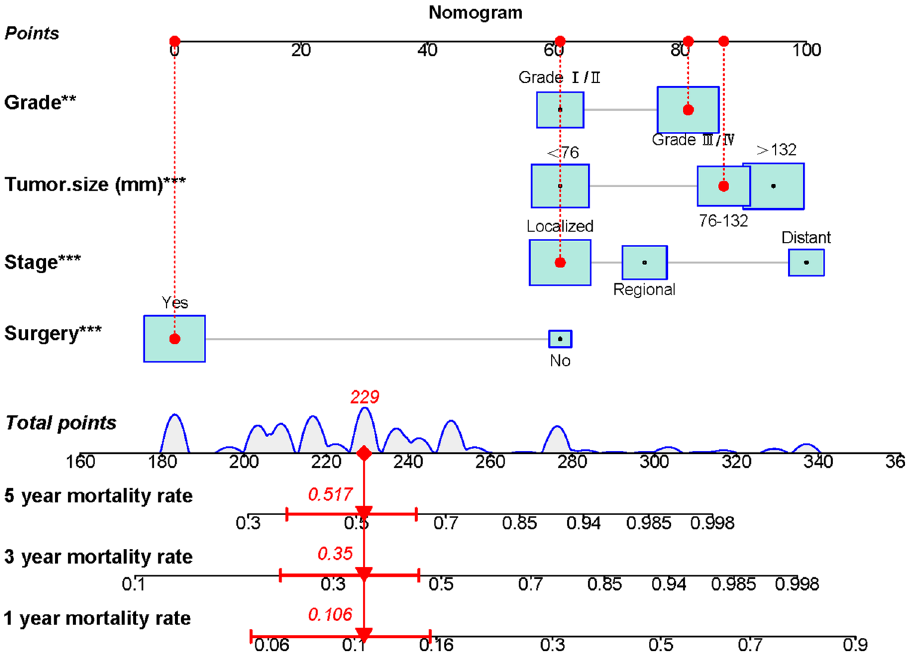
Figure 2. This prognostic nomogram predicts 1, 3, and 5 years OS probability in retroperitoneal leiomyosarcoma patients. Specifically, when a patient with primary retroperitoneal leiomyosarcoma comes to the clinic room for consulting his or her OS probability, we can sum each point of the above four independent prognostic factors to obtain a total point and draw a vertical line from total points row to the bottom timeline to obtain his or her mortality rate at the corresponding time. The survival probability at the corresponding time can be obtained by subtracting the mortality rate from 1. For example, a retroperitoneal leiomyosarcoma patient with a 100 mm localized metastasis and Grade III tumor and underwent surgery. The corresponding nomogram total points of this patients is 87 (100 mm) + 81 (Grade III) + 61 (Localized metastasis) + 0 (Underwent surgery) = 229, and his or her mortality rate at 1, 3, and 5 years were 10.6%, 35%, and 51.7%, respectively, while his or her corresponding OS probabilities at 1, 3, and 5 years were 89.4%, 65%, and 48.3%. Figure was generated